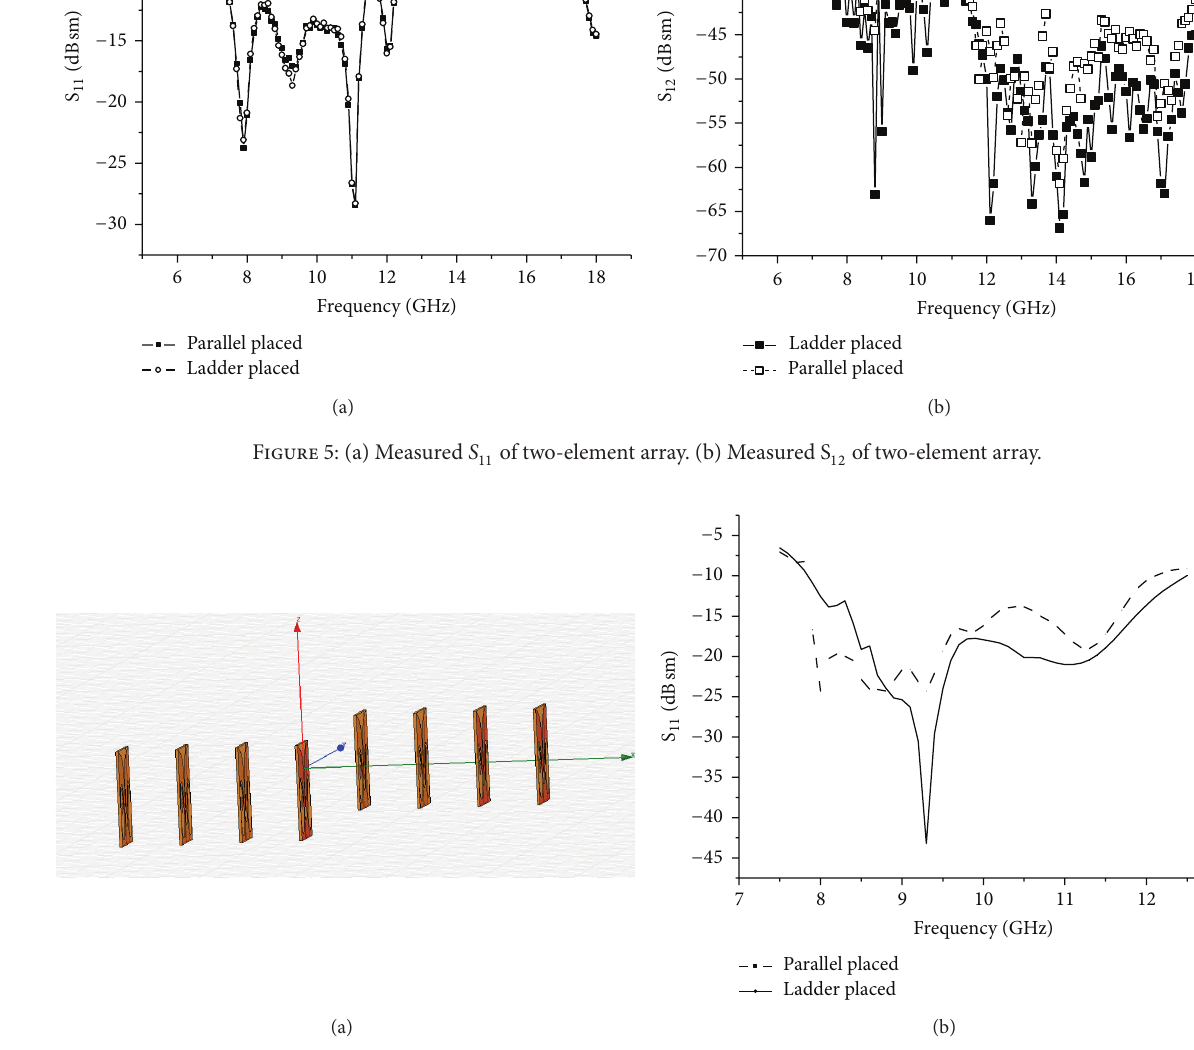
the gain reduction. Feeding network with phase-shifting function can also be employed to increase the maximum